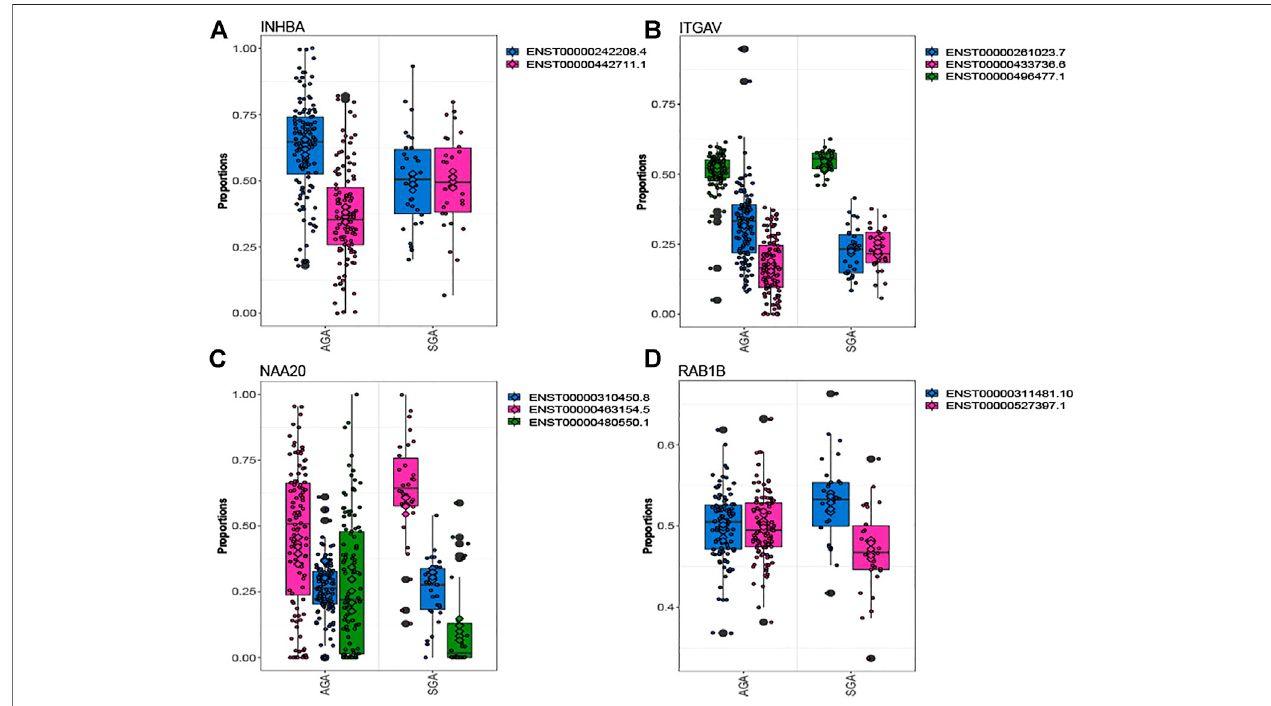
FIGURE 1 | Genes depicting differential transcript usage between SGA and AGA infants. Eighty-two genes demonstrated signi fi cant differential transcript usage. Shown are examples offourgenes,INHBA (A) ,ITGAV (B) ,NAA20 (C) , andRAB1B (D) .Thex-axis indicates theproportion oftotal measured geneexpression captured by individual transcripts.